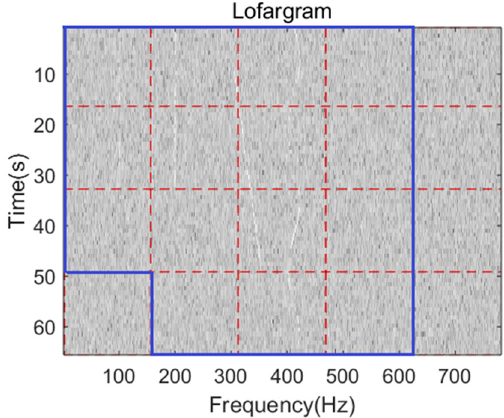
Figure 13. Lofargram screening results.